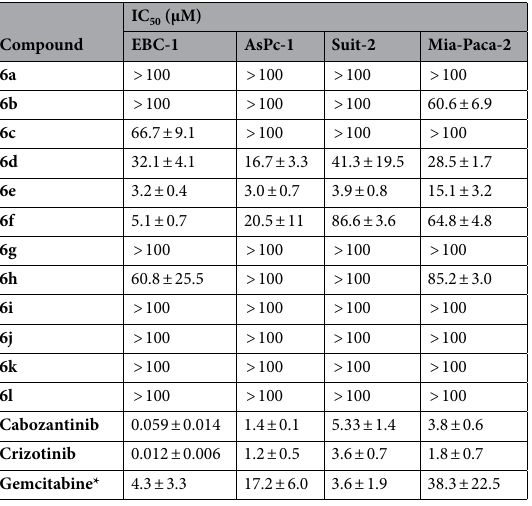
Table 2. Antiproliferative effects of synthesized compounds assessed by sulforhodamine B (SRB) assay. Antiproliferative effect was examined against pancreatic (AsPC-1 and SUIT-2) and lung cancer cells (EBC-1) overexpressing c-MET receptor and pancreatic cancer cells with low MET receptor expression (Mia-Paca-2). IC 50 values are the mean ± S.E.M. of 3–6 independent experiments. *Gemcitabine IC 50 values are expressed in nM.